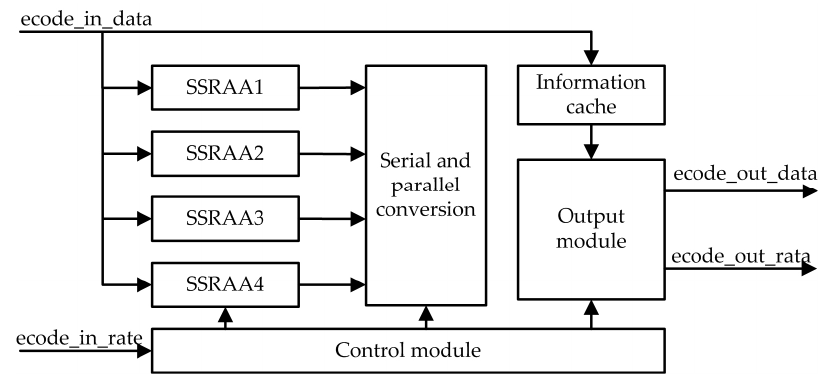
Figure 7. Coding module structure.